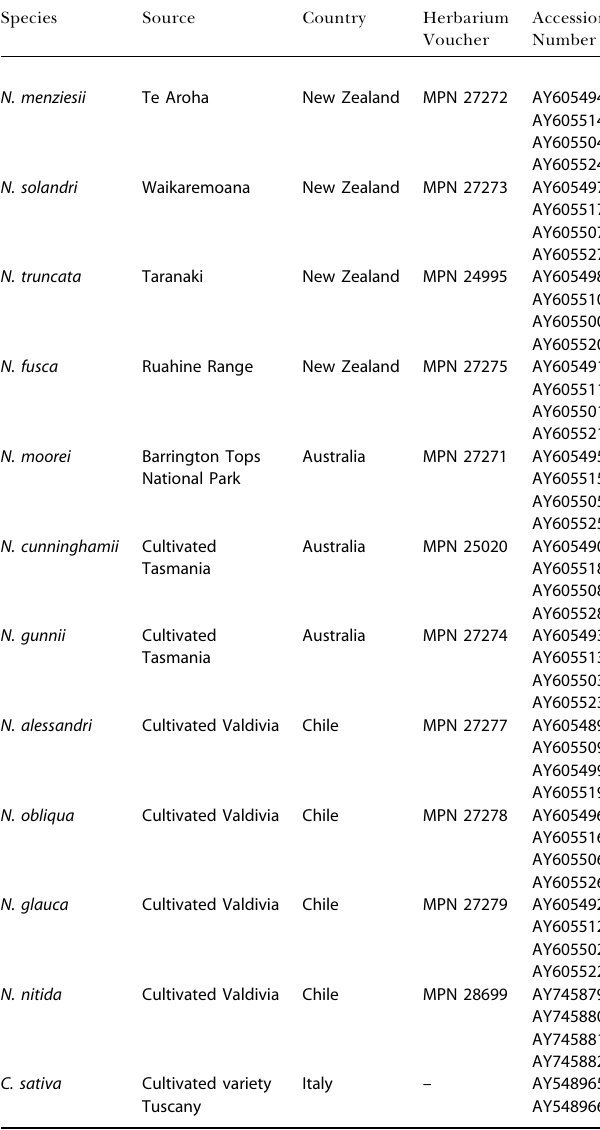
Table 2. Estimated Divergence Dates and Standard Deviations (in Brackets) of Different Nothofagus Clades Node Number/